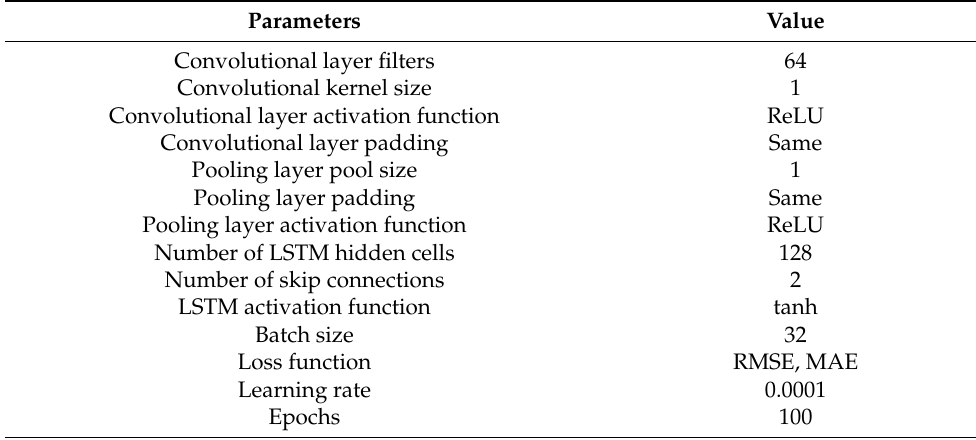
Table 4. Different parameter